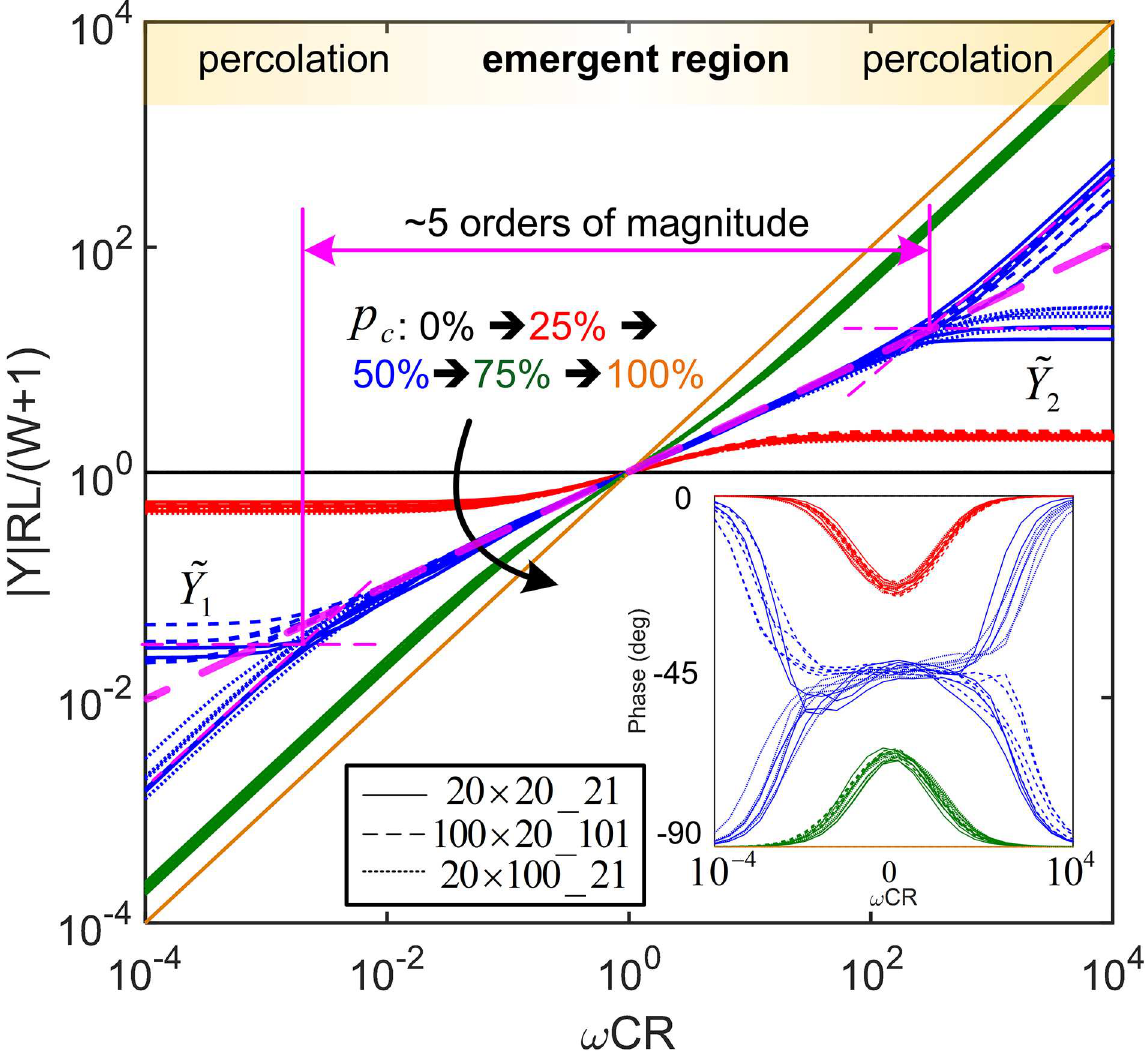
Fig 2. Normalised admittance module as a function of frequency. Numerical results obtained from three groups of differently configured networks (denotedas W × L_B ) are presented, with capacitorproportions, p c , varyingfrom 0% (correspondingcurves are shown in black) to, 25% (red), 50% (blue), 75% (green), and to 100% (brown). The phaseresponsesare depicted in the inset. For each network configurationwith a given capacitor proportion, five simulations have been